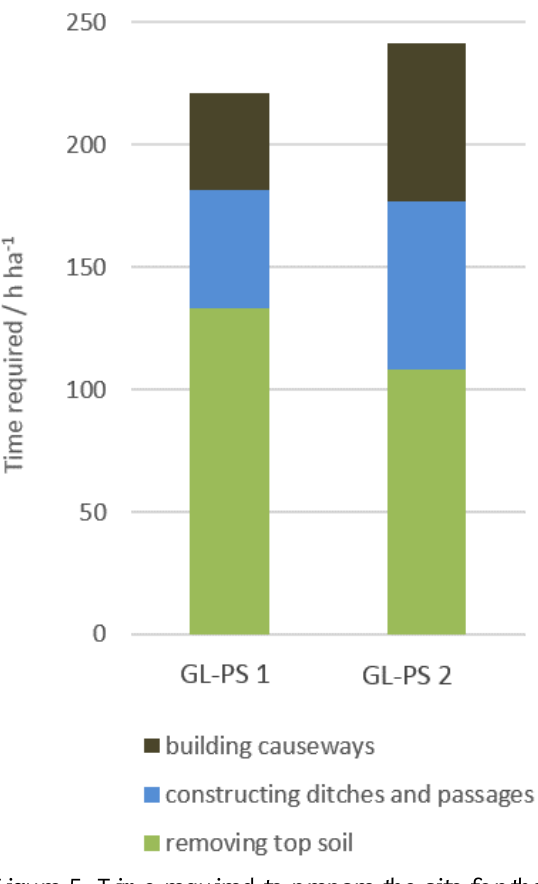
Figure 5. Time required to prepare the site for the pilot trial on former bog grassland, projected for a total area of one hectare to compare Production Systems 1 and 2 (Figure 2), with working steps